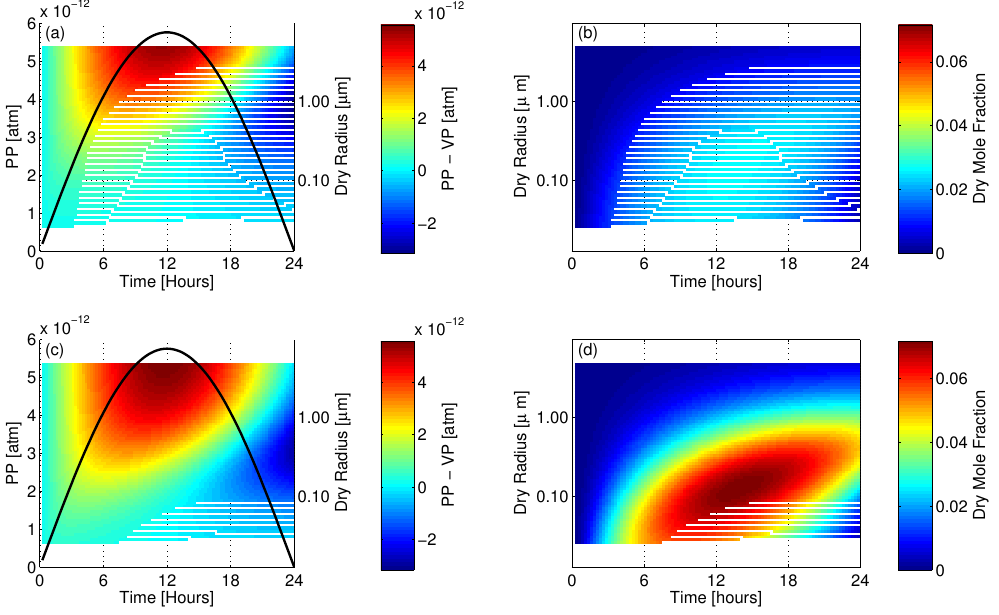
Fig. 8. Evolving condensed phase abundance and gas phase concentration for compound “12” as a function of time, assuming ideality ( a and b ) and using PD-FiTE ( c and d ). Panels (a) and (c) show the size-resolved differences between vapour pressure (VP) over aerosol particles and the gas-phase partial pressure (PP) (red indicates higher partial pressures; blue indicates higher vapor pressures), as well as the temporal variation in the partial pressure of compound “12” (black line). Panels (b) and (d) show the size-resolved dry mole fractions of compound “12” within the condensed-phase.